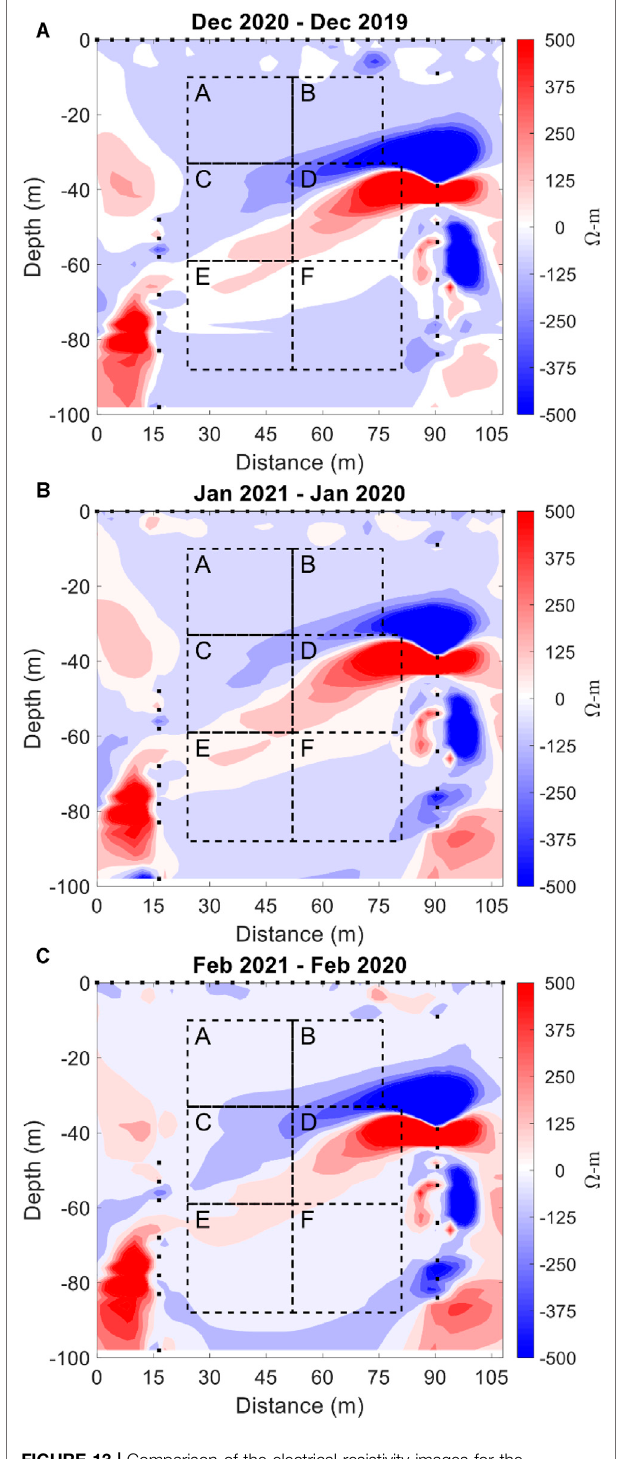
FIGURE 13 | Comparison of the electrical resistivity images for the months before and after a suspected creeping event. Differences in the electrical resistivity (A) between December 2019 and 2020, (B) between January 2020and 2021, and (C) betweenFebruary2020and 2021. For